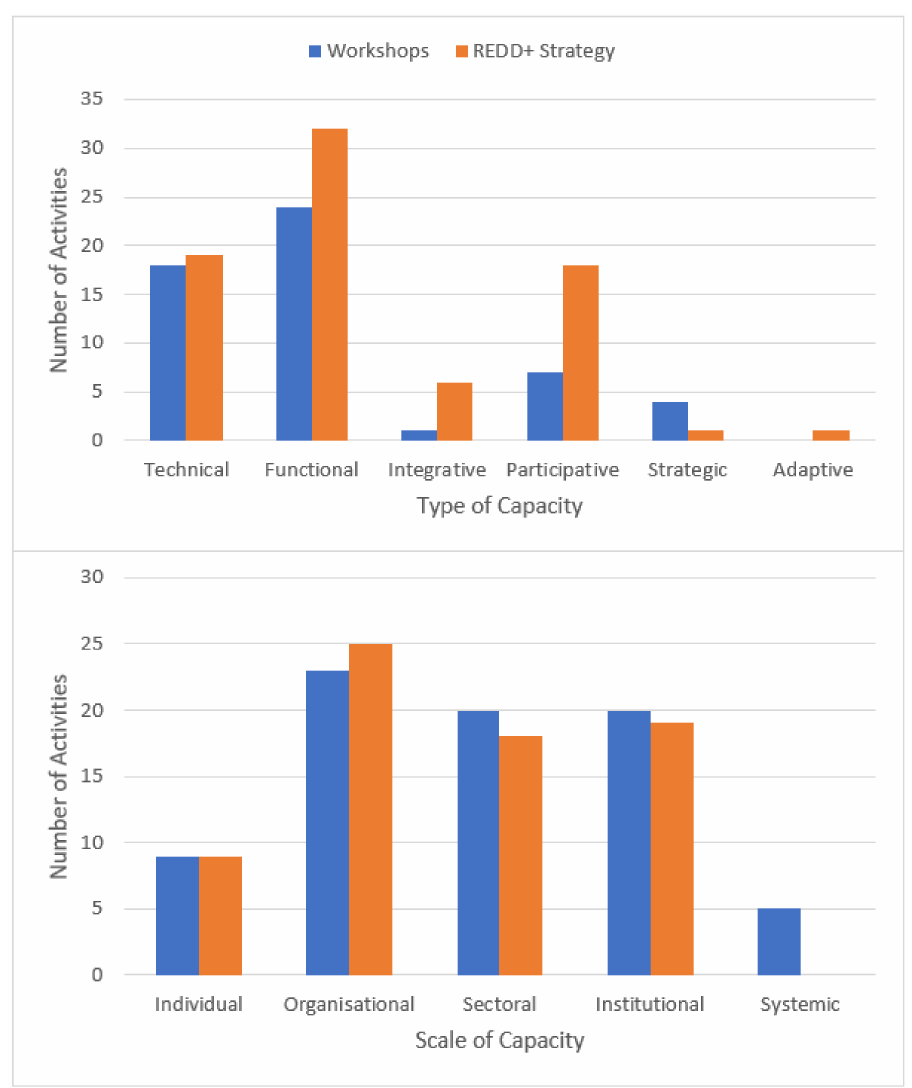
Figure 2. Different types and scales of capacity building activities identified in stakeholder workshops and the DRC REDD+ Strategy. Note: activities might include more than one type or scale of capacity, and so numbers of activities are not directly